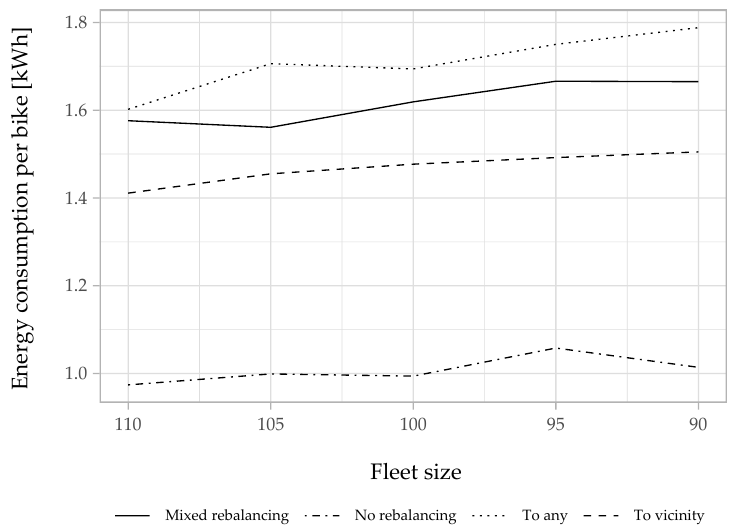
Figure 12. Energy consumption for rebalancing per bike for different fleet sizes.